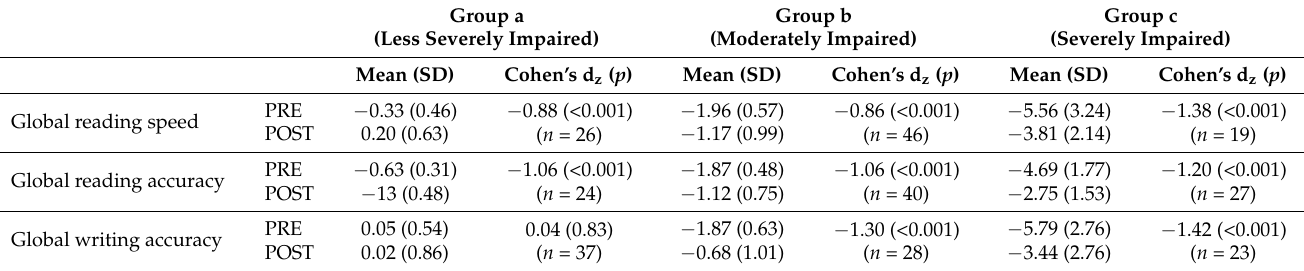
Table 2. Mean Z-scores (SD in parentheses) and effect sizes (Cohen’s d z ) of the three different impairment severity groups (NB for each comparison, the severity of impairment is established based on the parameter being compared: reading speed, reading accuracy, writing accuracy, in